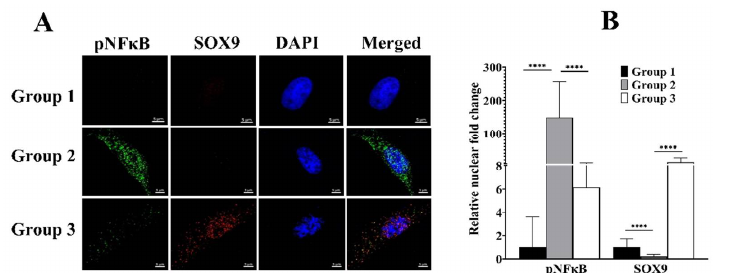
Figure 5. Localization of SOX9 and pNF κ B in MSCs exposed to IL1 β . MSCs were seeded on coverslips and treated as depicted in Figure 1. Coverslips were fixed and double stained for pNF κ B (green fluorescence) and SOX9 (red fluorescence) antibodies, and nuclei were counter stained with DAPI (blue fluorescence). ( A ) Images were captured using 63× magnification and presented. ( B ) Fluorescence intensity was quantified using ImageJ TM software ( n = 30). Bar graph represents mean ±95% confidence interval; p values indicate statistically significant differences. (**** p < 0.0001) and the scale bar represents 5 µm.